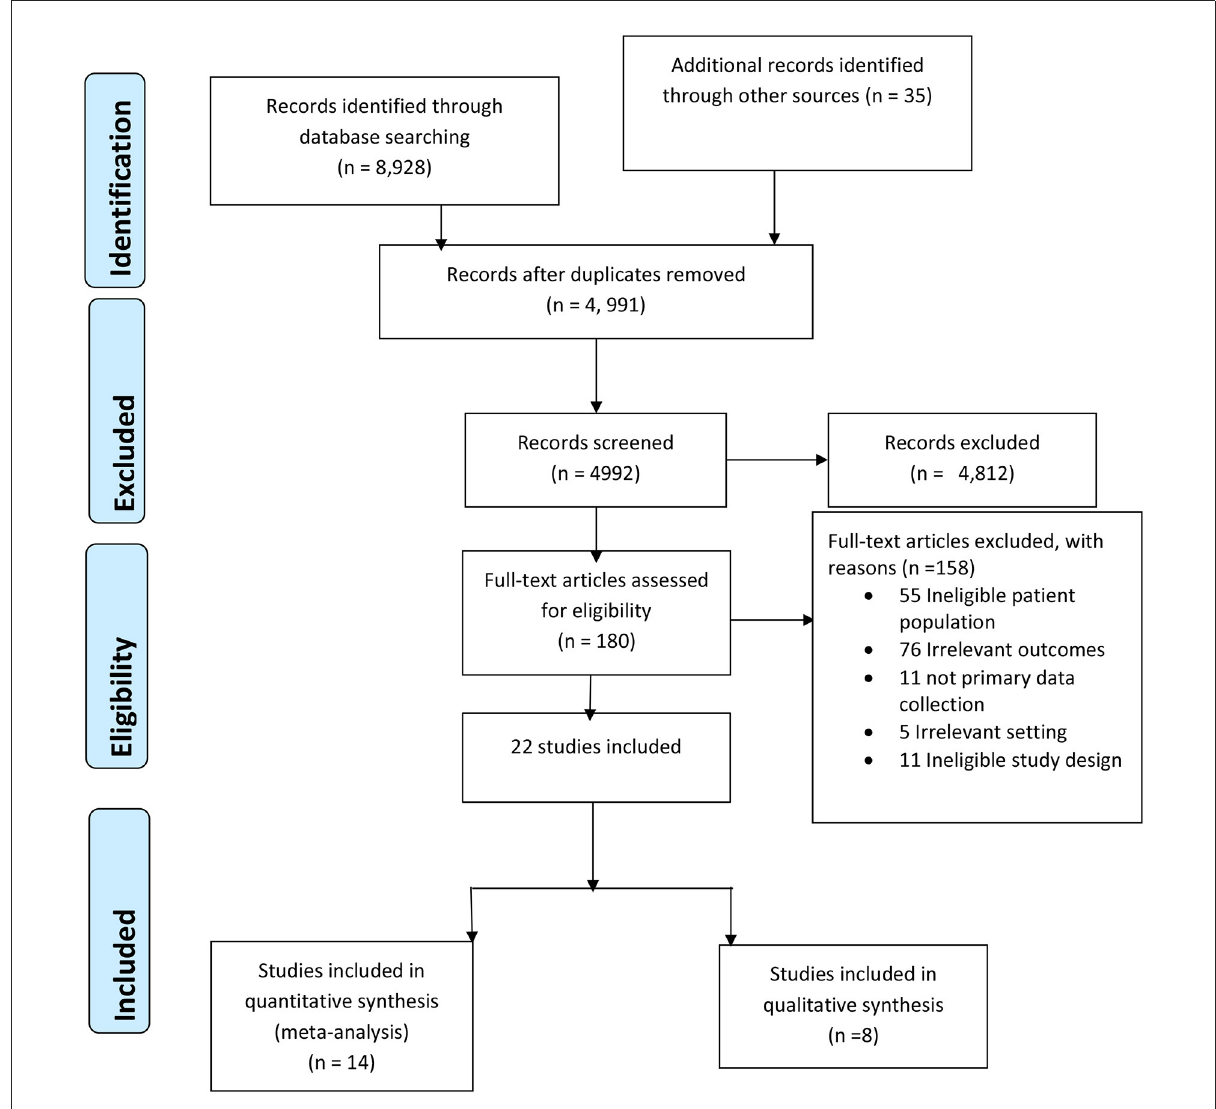
FIGURE1 PRISMA 2009 flow